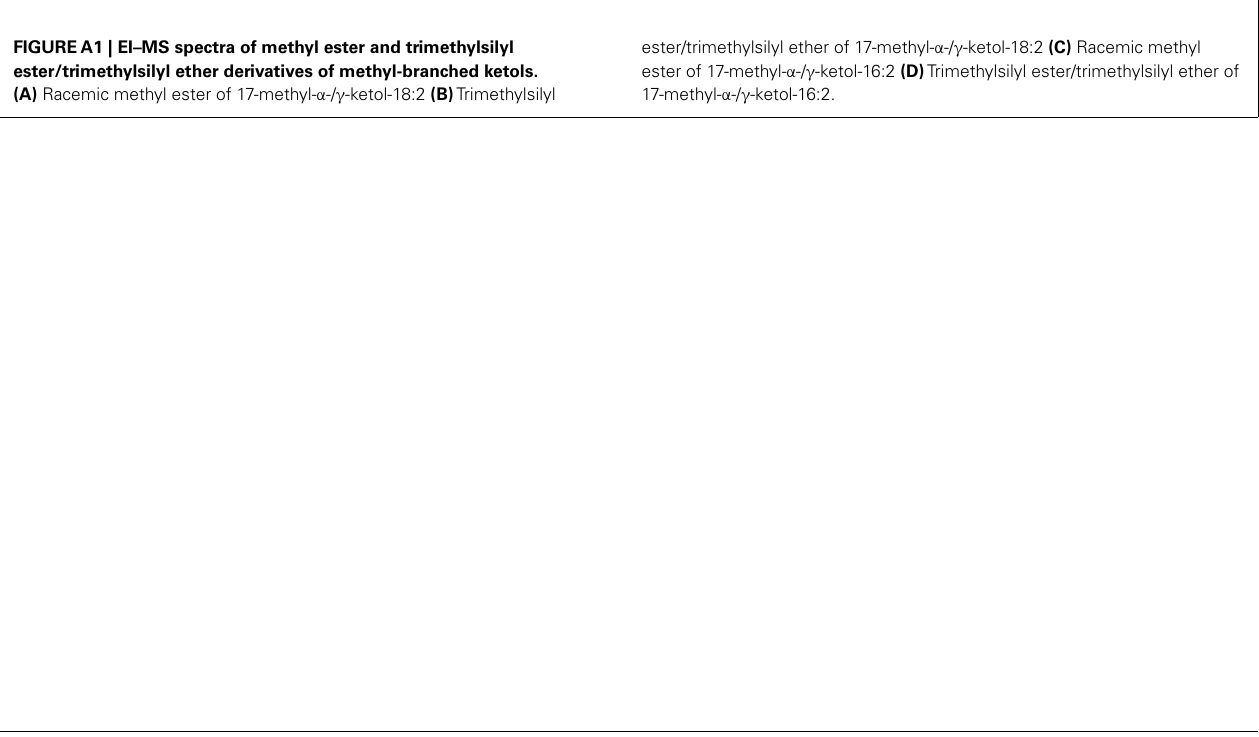
ester/trimethylsilyl ether of 17-methyl- α -/ γ -ketol-18:2 (C) Racemic methyl ester of 17-methyl- α -/ γ -ketol-16:2 (D) Trimethylsilyl